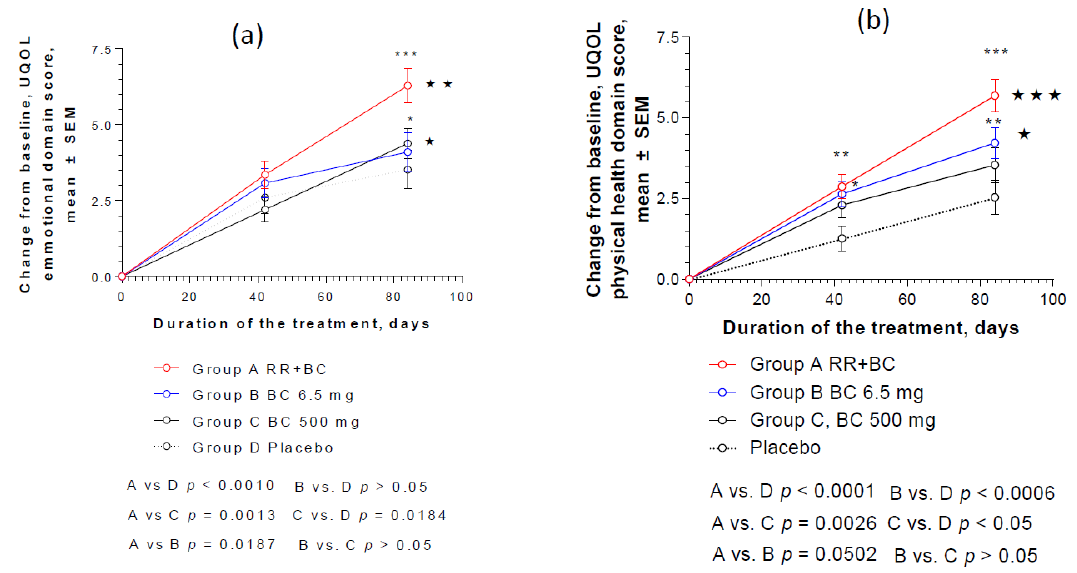
Figure 6. Effects of RR-BC (Group A), BC (Group B), BC500 (Group C), and placebo (Group D) on ( a ) emotional and ( b ) physical health domains of quality of life after 12 weeks (84 days) of treatment, as assessed by the UQOL scale: ( a ) statistically significant interaction effects between treatment groups and response (change from the baseline of physical UQOL, mean ± SEM) over time showed significant difference between groups A, B, and C vs. placebo (respectively p < 0.0001, p = 0006, p < 0.05), as well as group A vs. group C ( p < 0.001), but not the two BC groups, B and C (two-way ANOVA); ( b ) statistically significant interaction effects between treatment groups and response (change from the baseline of emotional UQOL, mean ± SEM) over time showed significant difference between groups A vs. B, C, and placebo groups (respectively, p = 0.0187; p = 0.0013; p < 0.001). Significance of difference between groups at various time points, calculated by Bonferroni post-test, is expressed by symbols * p < 0.05, ** p < 0.01, *** p < 0.001, ns: not significant (A, B, C vs. placebo); and * p < 0.05, ** p < 0.01 *** p < 0.001 (A vs. B and C).